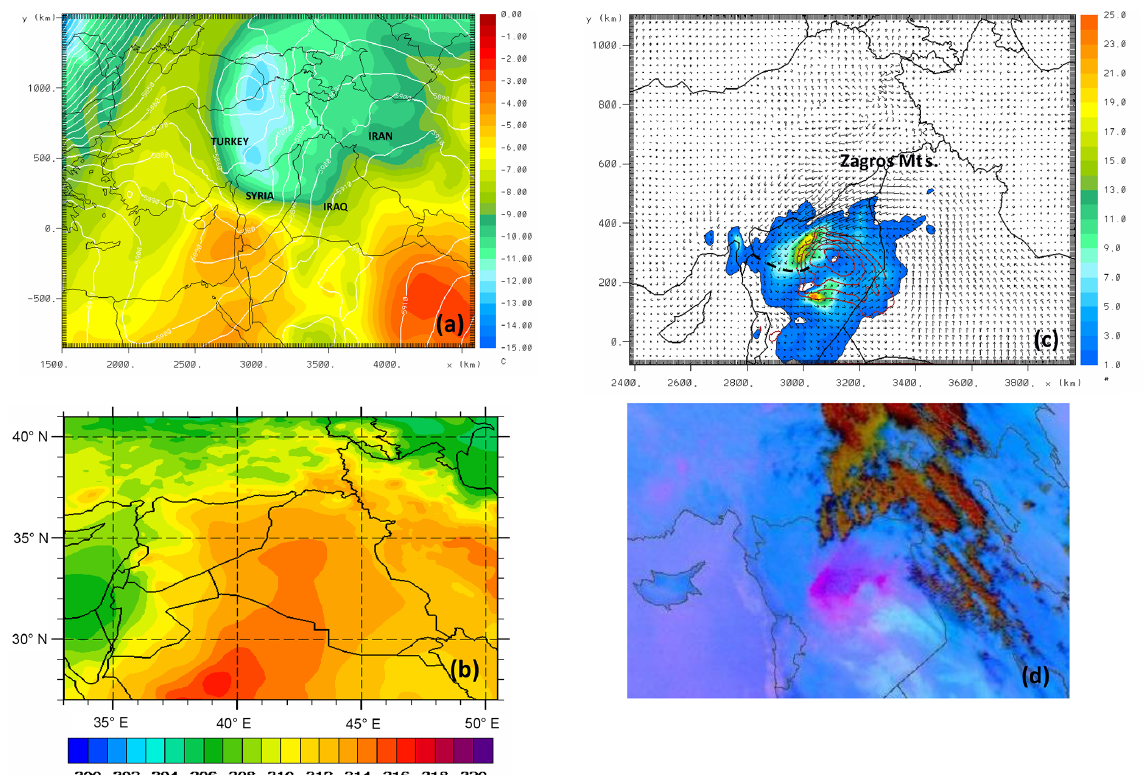
Figure 4. (a) Model geopotential height contours (every 10m) and temperature (colour scale in ◦ C) at 500mbar on 6 September 2015, 00:00UTC. (b) Model 1000–700mbar thickness (dam) on 6 September 2015, 00:00UTC. (c) Model AOT (colour scale), geopotential height at 925mbar (red contours from 740 to 757.5m every 2.5m), and wind vectors at 925mbar. The dashed line denotes the outflow boundaries from the Zagros Mountains. (d) MSG-SEVIRI dust RGB at 08:00UTC, 6 September 2015.